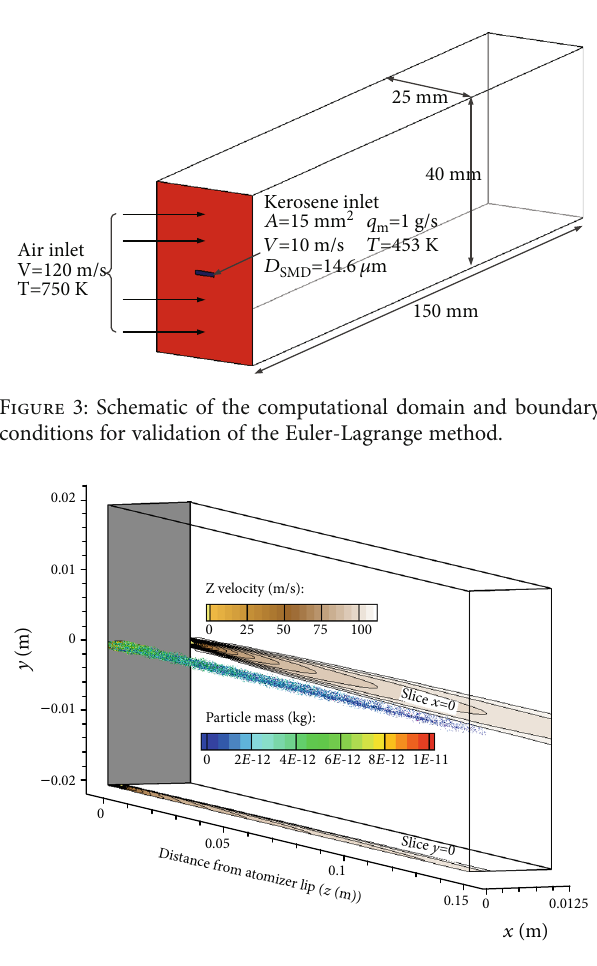
Figure 4: Spray trajectories and distribution of streamwise velocity component in the symmetry planes ( x = 0 and y = 0 ) of the duct.